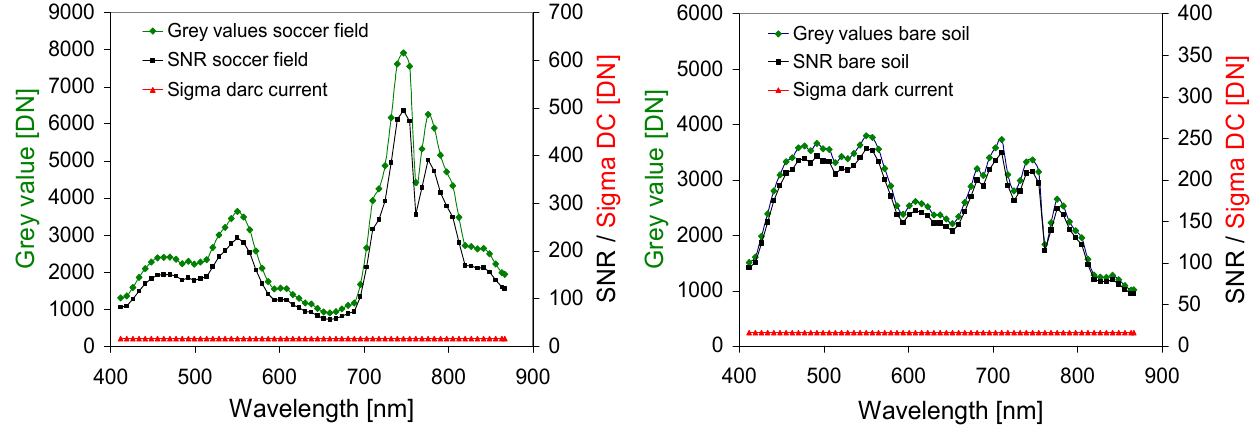
Figure 5. Grey value spectrum and corresponding SNR of AVIS-2 for measurements of a soccer field (left) and bare soil (right) acquired on August 30, 2005.